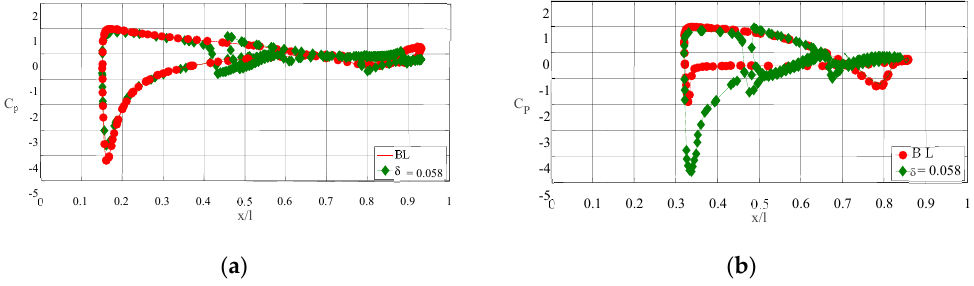
Figure 9. Pressure coefficient C p at ( a ) α = 40° and ( b ) α = 60° for δ = 0.0583 and x/l chosen as the length of the airship.